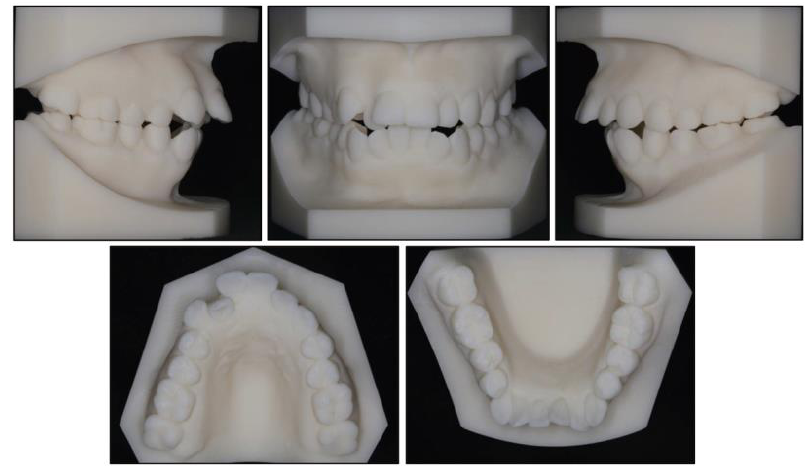
Figure 2. Pretreatment dental casts.